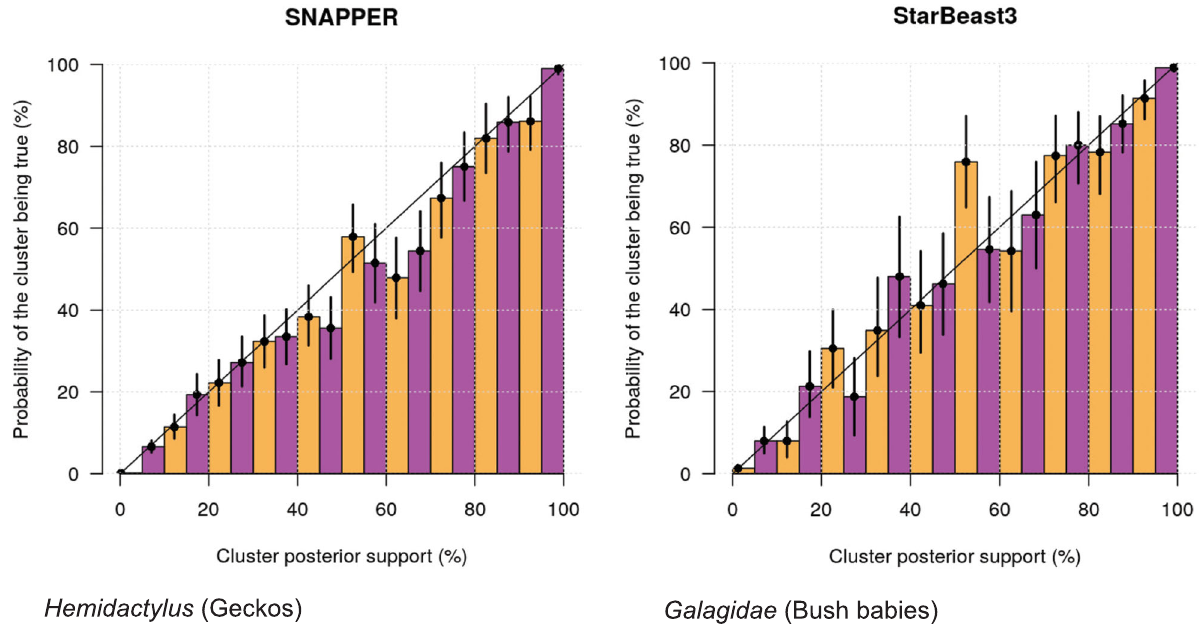
Fig. 2 Identi fi cation of clusters under the YSC model. Top: Validating SNAPPER and StarBeast3 for their abilities to recover clusters from simulated data. Each coloured bar has a 95% Binomial credible interval based on the number of clusters used to estimate its probability. Bottom: Species identi fi ed in the gecko (left) and primate (right) datasets, under the YSC model. The clustering scheme presented is the one which occurred with the maximal-posterior probability across all values of threshold ϵ that are labelled with a*. The marginal posterior support is indicated below each cluster (for ϵ = 10 − 2 ). Note that the remaining taxa in the bush baby dataset are omitted from the fi gure because they exist as singleton